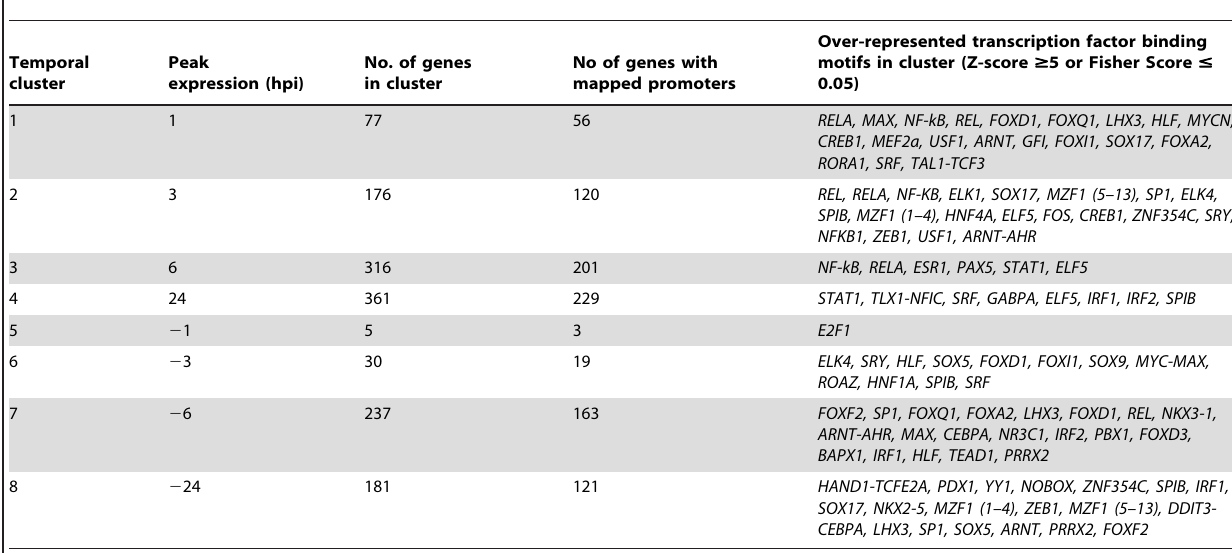
Table 1. Enriched transcription factor binding motifs within temporal gene expression clusters following infestation with P. ovis.